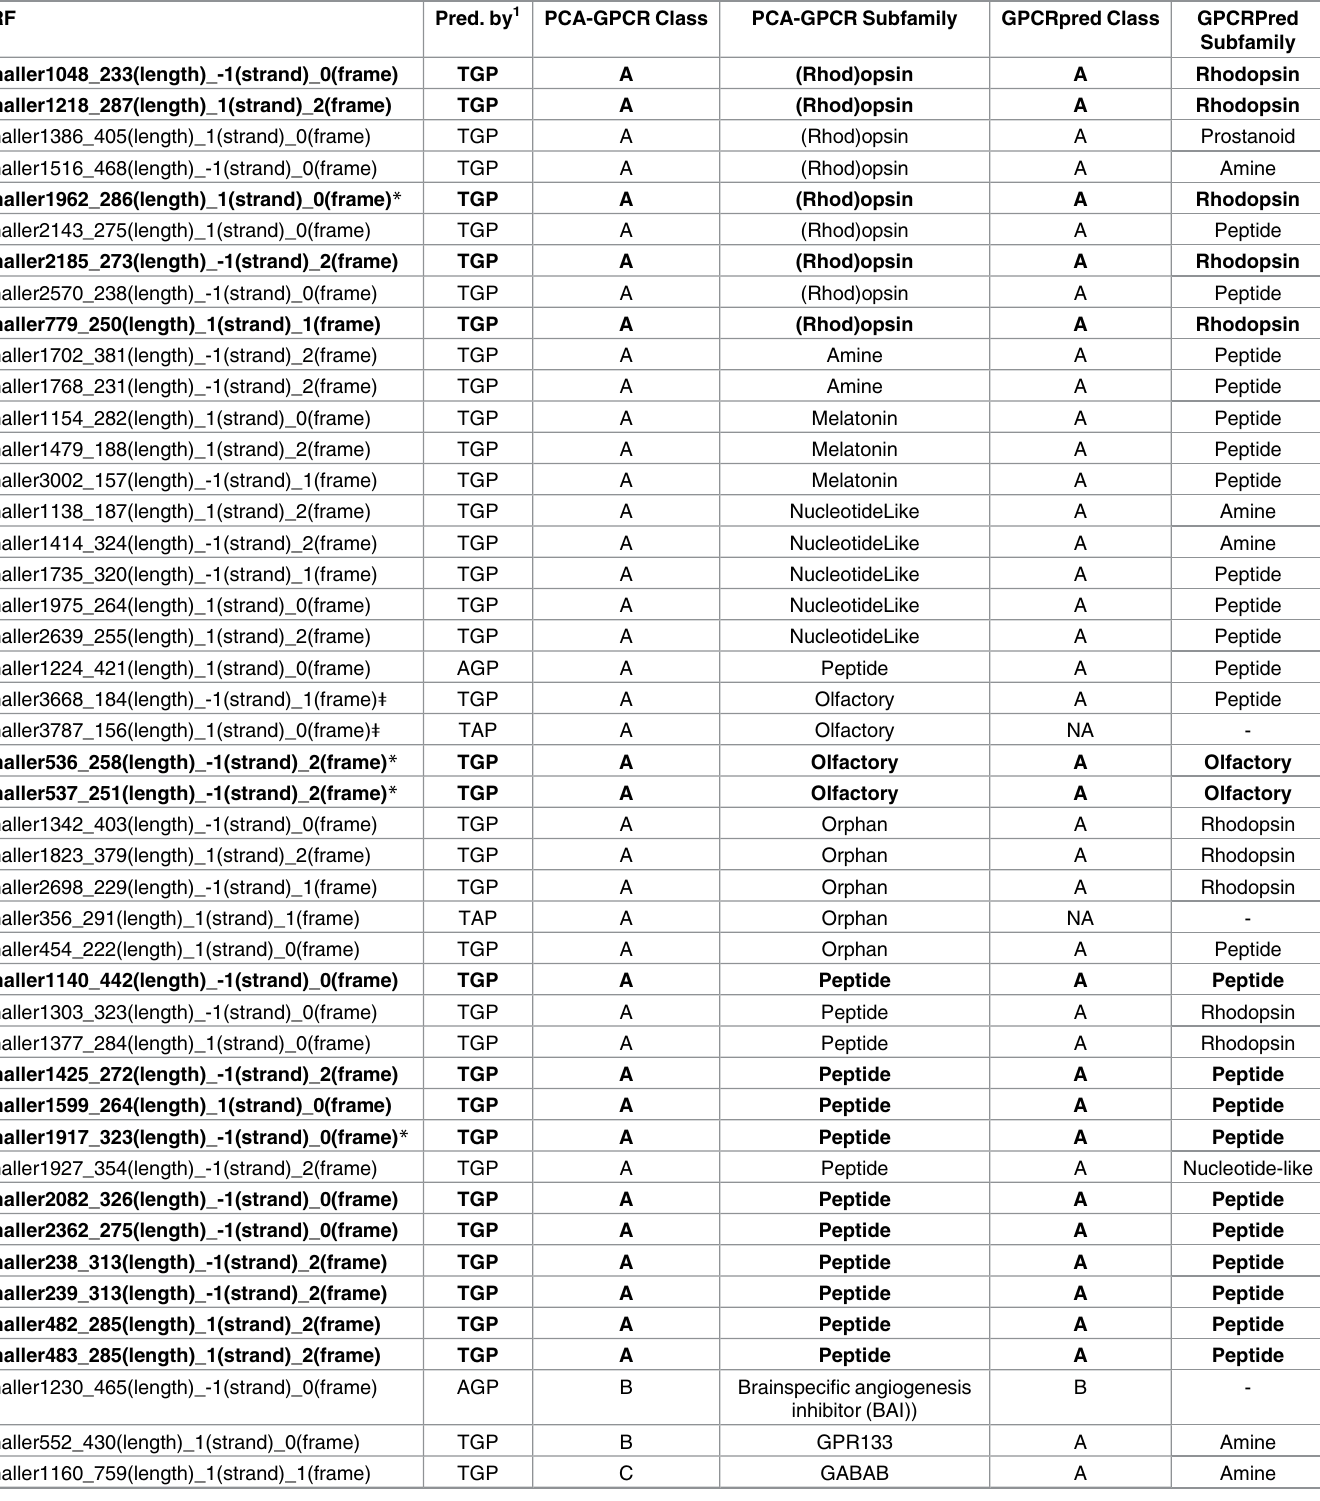
Table 3. ORFs predicted to be GPCRs by at least 3 approaches.